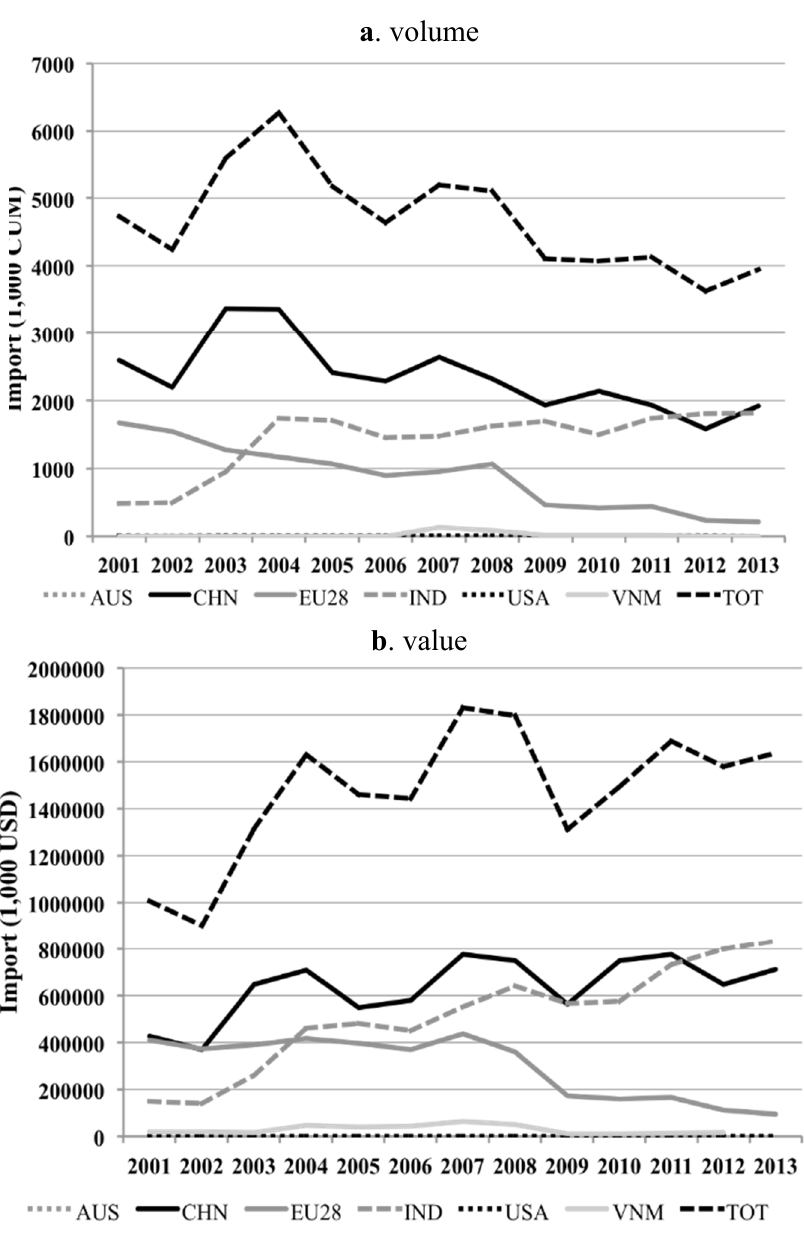
Figure 2. Imports of tropical logs—in volume ( a ) and value ( b )—by selected countries (2001–2013). Source: own elaboration from